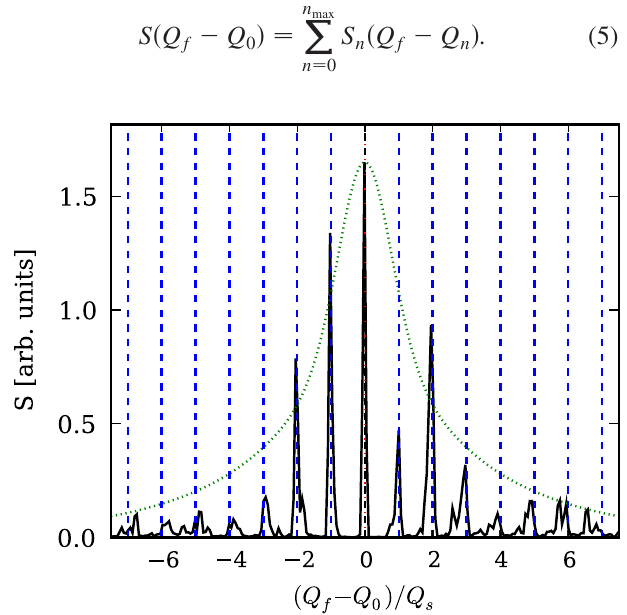
FIG. 1. (Color) Transverse simulation noise spectrum S (cid:2) ð Q f Þ for a matched bunch. The dashed blue lines indicate the syn- chrotron satellites at kQ s . The dotted green curve represents the Schottky spectrum for the equivalent coasting